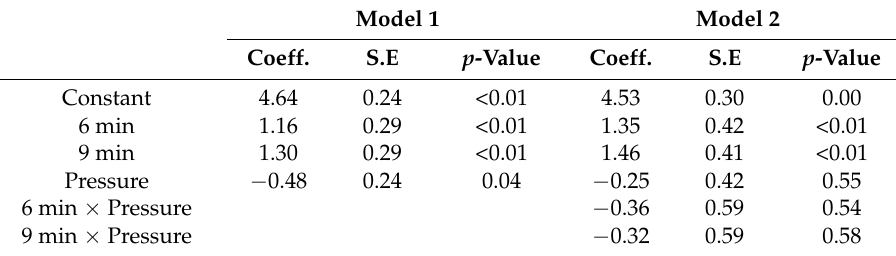
Table 4. Results of regression analysis of the supplementary